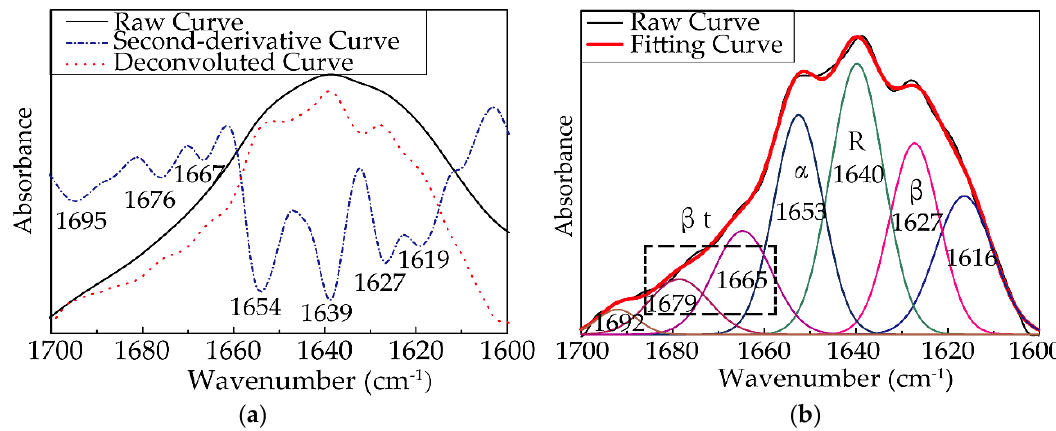
Figure 5. (a) Raw curve (black line), deconvoluted curve (red dotted line), and second-derivative curve (blue dashed and dotted line) of the amide I absorption band of 25-F1 sample; (b) The quantitative analysis of the amide I band for 25-F1 sample (the black line is the original spectrum, the red line is the fitting spectrum, and the colorful lines are the contributions to the spectra from each type of secondary structure).